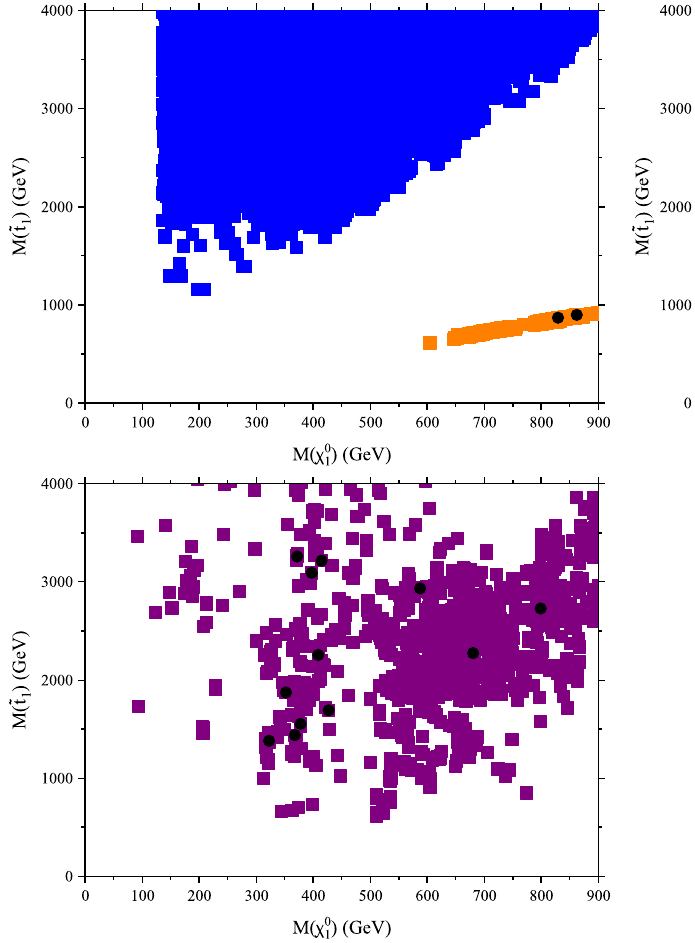
Fig. 1 Light stop mass M ( (cid:2) t 1 ) as a function of the lightest neutralino ) for the four regions of the model space we study in this mass M ( (cid:2) χ 0 1 work. The stop coannihilation strip can be observed in the upper left plot space. Notice that there is no intersection between the Light Stop Coannihilation and pure Higgsino regions, though a more detailed anal- ysis relaxing the higgsino and light stop coannihilation requirements we applied here is in progress [50] to ascertain any potential union